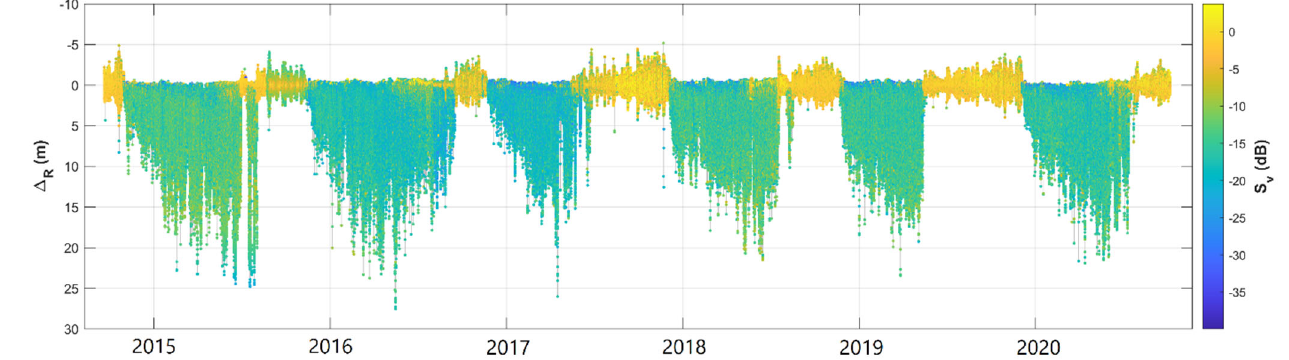
Figure 6. ∆ R (m) time series for the full-resolution six-year AZFP dataset at the CEO site in the NE Figure 6. 𝛥 (cid:3019) (m) time series for the full ‐ resolution six ‐ year AZFP dataset at the CEO site in the NE Chukchi Sea, color-shaded by S v Chukchi Sea, color ‐ shaded by 𝑆 (cid:3049) (dB).